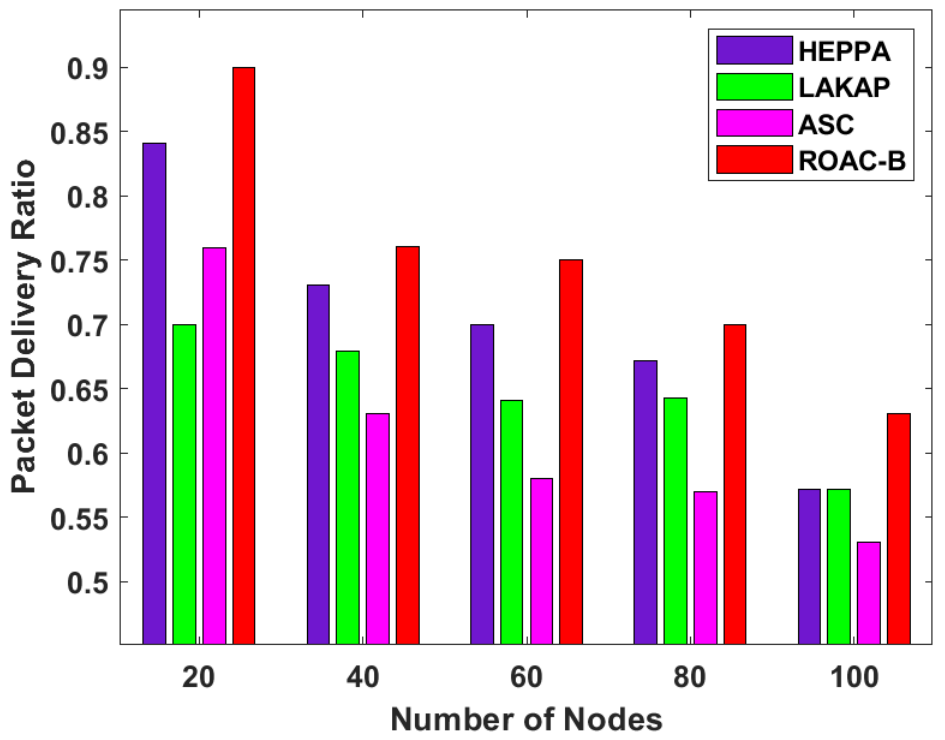
Figure 8. Packet delivery ratio analysis of ROAC-B technique under a denial of service attack.